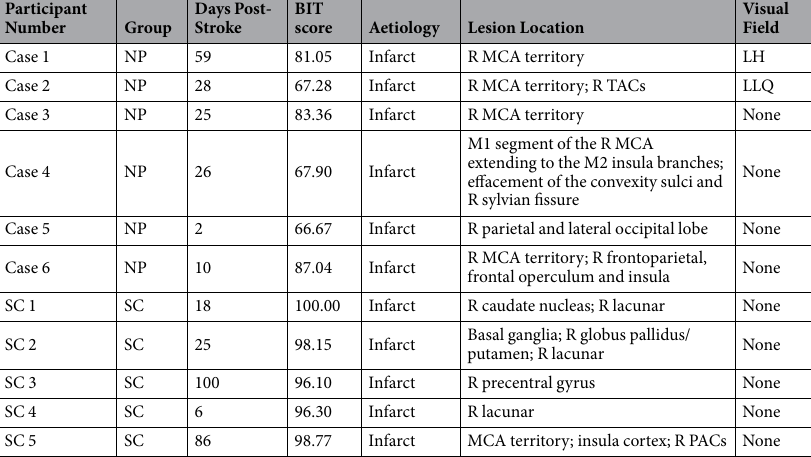
Table 1. Number of Days Post-Stroke, BIT score, Aetiology, Lesion Area and Visual Field Defects for the Neglect Patients (NPs) and Stroke Controls (SCs). NP = Neglect Patient; SC = Stroke Control; R = Right; MCA = Middle Cerebral Artery; TACs = Total Anterior Circulation infarct; LH = Left Hemianopia, LLQ = Lower Left